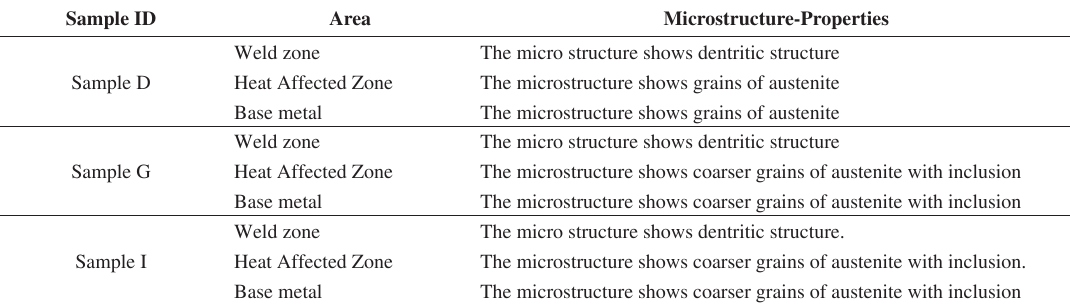
Table 8. Microstructure